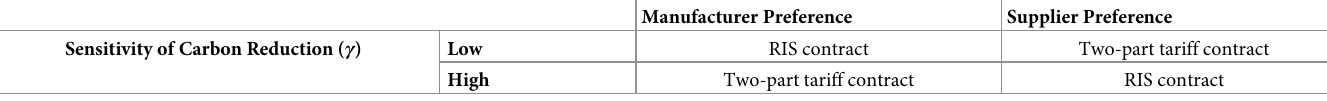
Table 5. Contract preferences of manufacturer and supplier at low and high value of γ